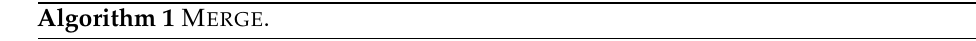
Algorithm 1 M ERGE